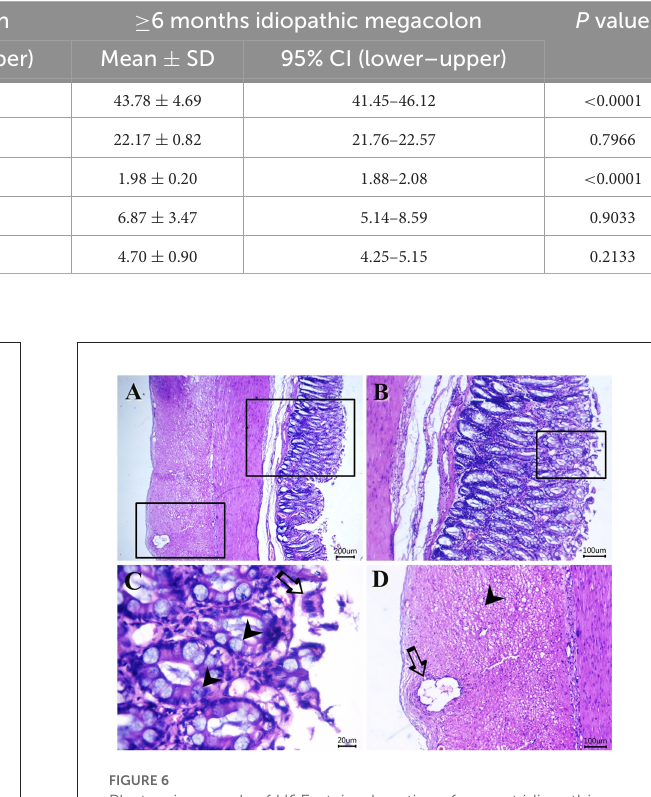
of choice (18), however, its outcomes are still challenging (3).